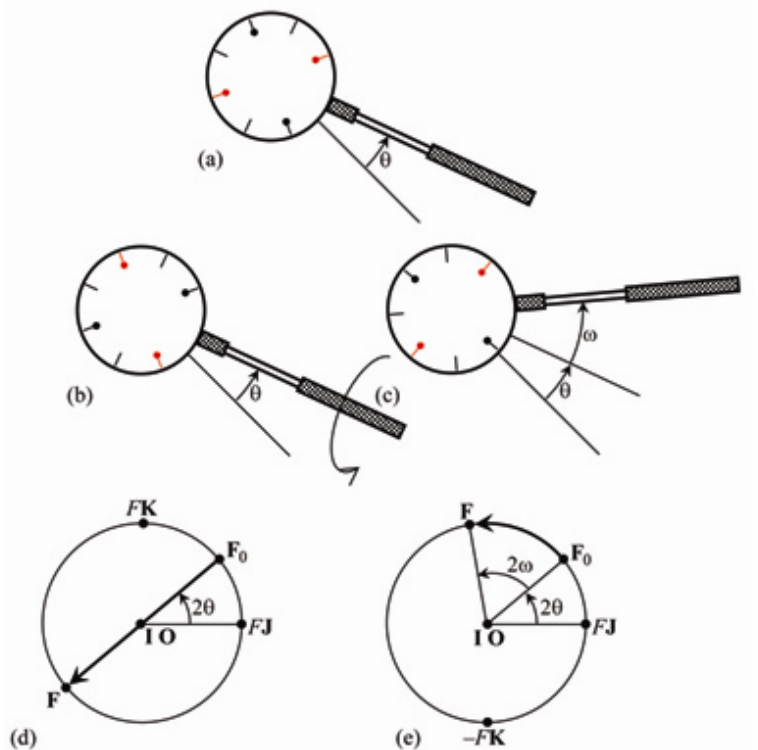
Figure 11 Operations in physical space on a general Jackson cross-cylinder in an arbitrary orientation and the corresponding changes in the abstract space. In (a) the handle is at angle θ anticlockwise from the primary orientation. The lens has power 0 F on the circle in (d) at angle 2 θ . Flipping takes the lens from (a) to (b) and the power diametrically across the circle to F in (d). Turning the lens anticlockwise through angle ω (to (c)) takes the power around the circle anticlockwise through angle 2 ω to F in (e).